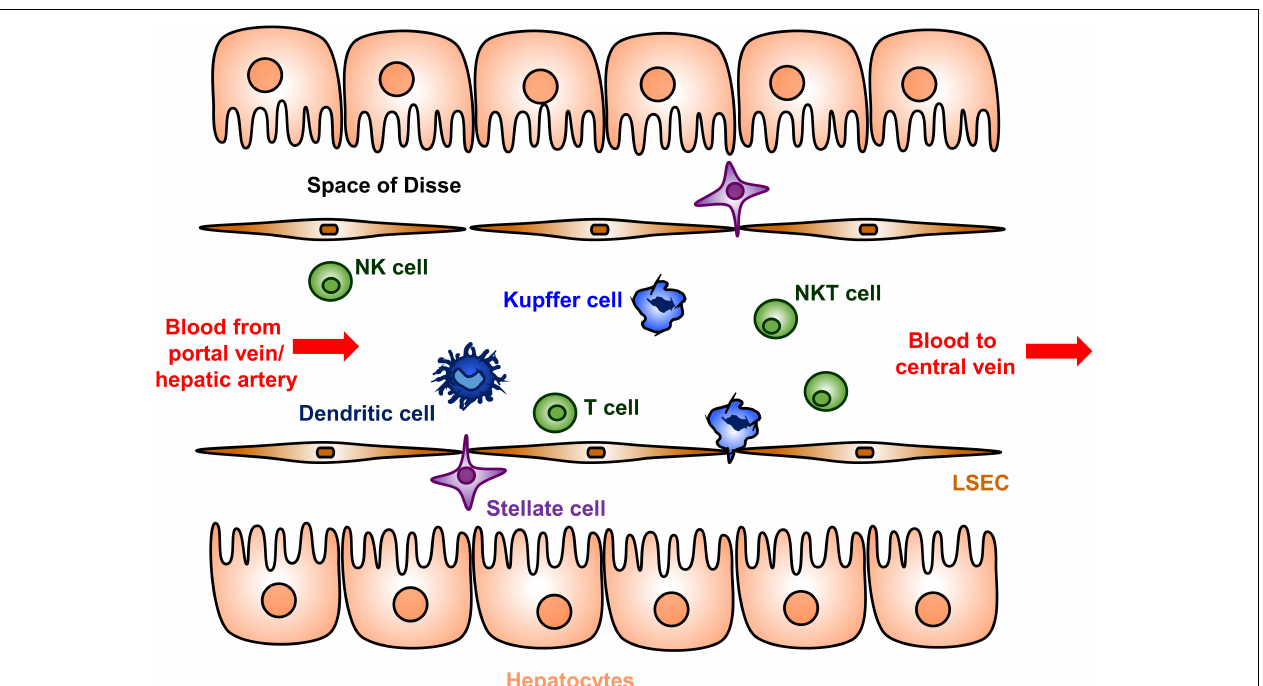
FIGURE 1 | Cellular anatomy of the liver sinusoid. Blood enters the liver from the portal vein and hepatic artery, flows through a network of sinusoids schematically represented here, and then exits via the hepatic central vein. The sinusoids are lined by a fenestrated layer of specialized liver sinusoidal endothelial cells (LSECs), which are the endogenous site of most FVIII secretion. The LSECs shield the hepatocytes from direct sinusoidal blood flow by creating the Space of Disse, which contains the stellate cells. Dendritic cells, Kupffer cells, T cells, natural killer (NK) cells, and natural killer T (NKT) cells are abundantly present in the sinusoidal lumen. Hepatic antigen presenting cells include dendritic cells, Kupffer cells, LSECs, stellate cells, and hepatocytes. The hepatocyte microvilli can interact with luminal T